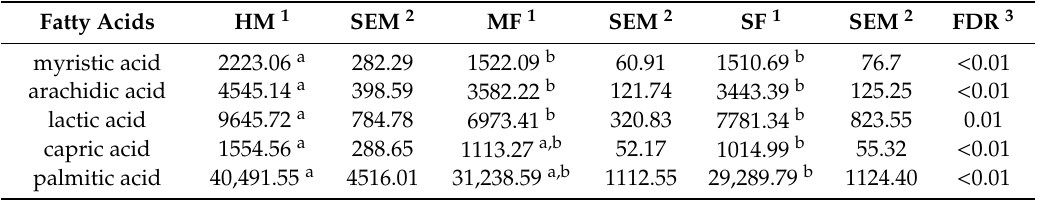
Table 4. Average abundances (quantifier ion (quantion) intensities) of urinary fatty acids significantly di ff erent when comparing human milk (HM; n = 93), cow’s milk-based formula (MF; n = 80), and soy-formula (SF; n = 76) diet groups of infants at 3 months of age.